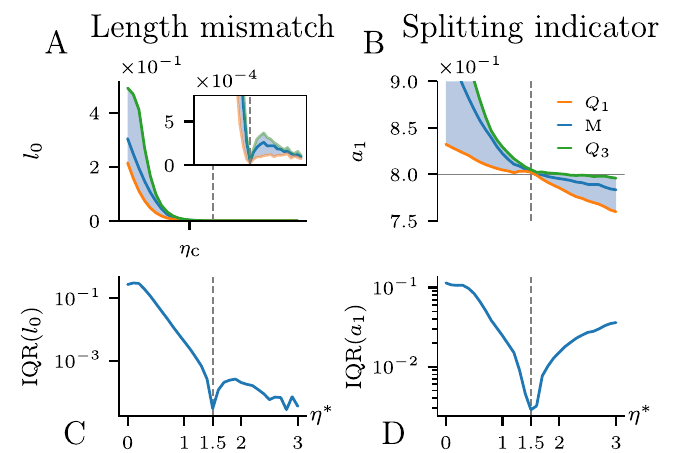
Figure 6. The Backward Evolution Algorithm applied to a synthetic Laplacian network. ( A ) Original network created with η 0 = 1.5 to which the algorithm was applied. ( B – D ) Quartiles of the collected values of the local symmetry, overshoot, and angular deflection. ( E – G ) Median of the absolute value of the corresponding metric plotted in a logarithmic scale. The pronounced minima allow us to estimate the correct η 0 (marked with the black dashed line on each plot). The results show that the BEA can precisely reconstruct the growth exponent of a given network.